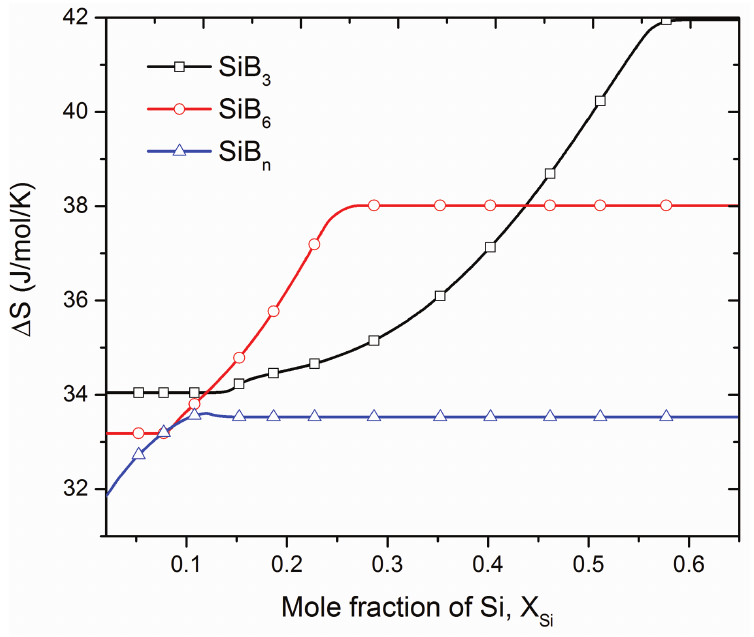
Figure 5: The change in entropy ( Δ S) with the function of mol % of Si at 1100